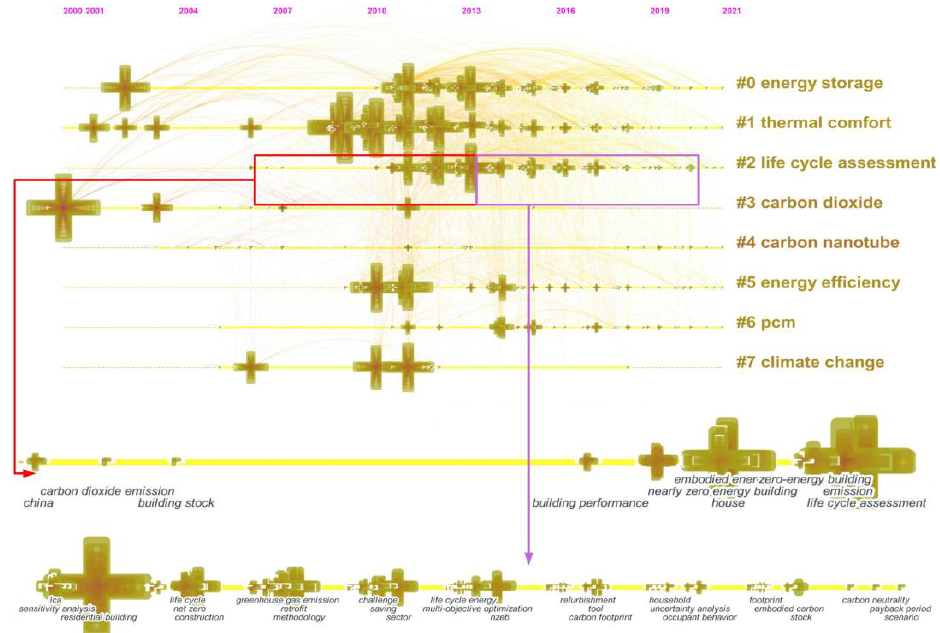
Figure 4. Timeline visualization of the keywords (2000 – 2021).